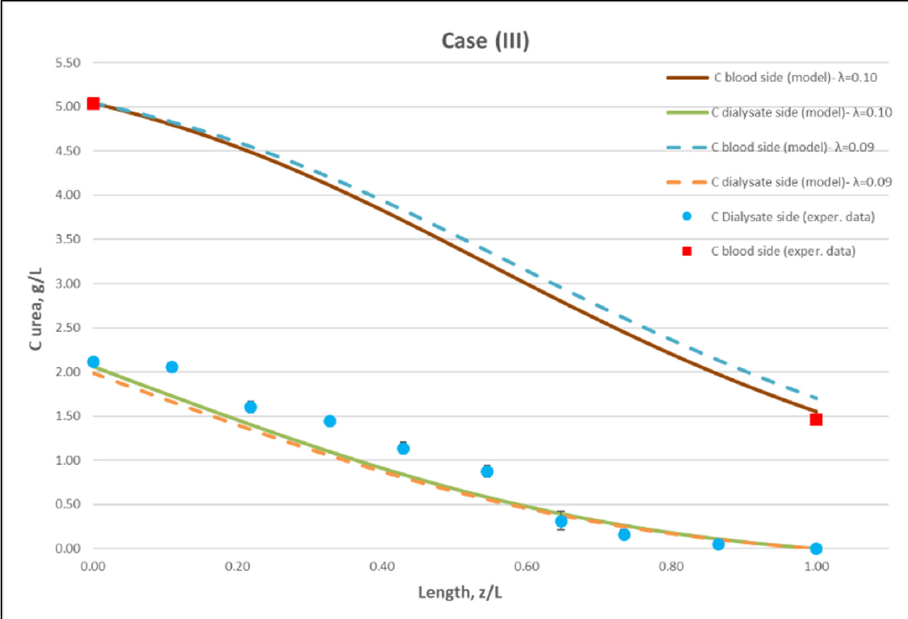
Figure 11. Comparison of measured local urea concentration C D in the dialysate-side, with model predictions, at flow rates Q Blood = 300 mL/min, Q Dialysate = 500 mL/min (Case III). The predicted blood-side urea concentration C B profile is also presented. The points ( ● and ■ ) designate measured values of urea concentration. Table 3. Comparison of predicted and experimentally determined urea clearance.